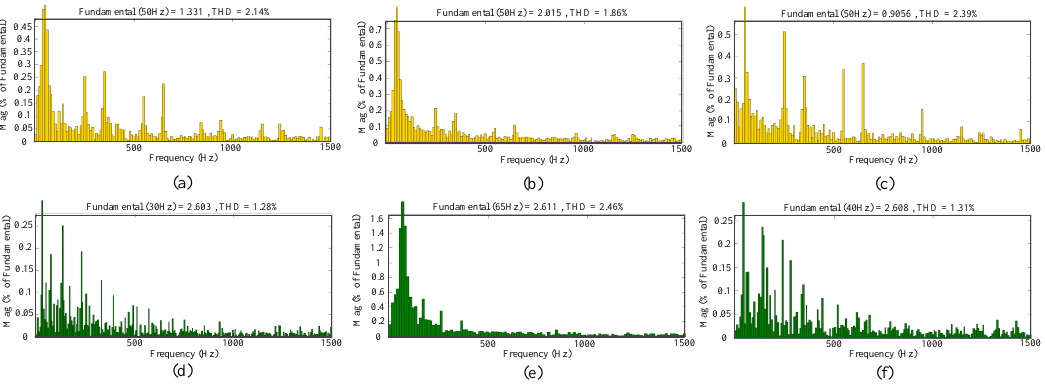
Figure 15. THD analysis of output current with ( a ) 50%; ( b ) 80% ;( c ) 20% of full-load current; ( d ) 30 Hz;